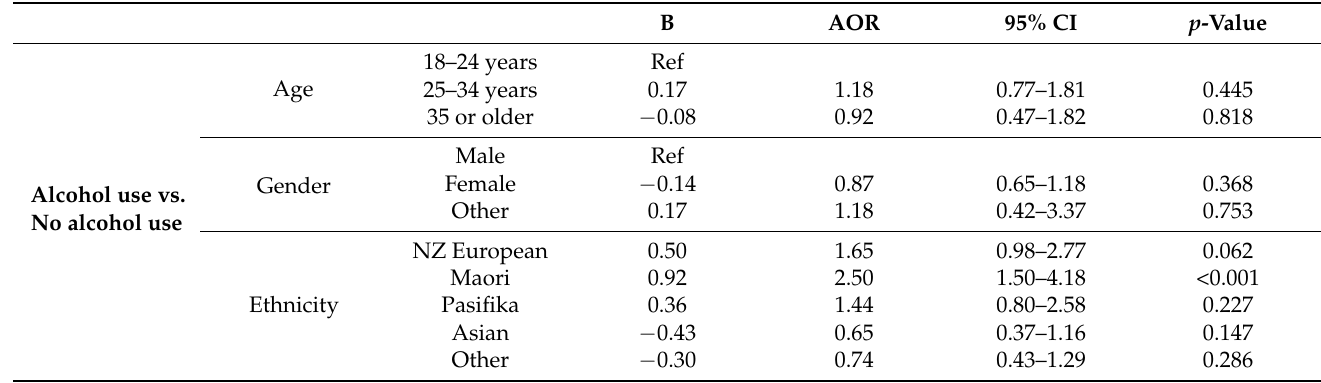
Table 3. Binary logistic models predicting the likelihood of having family/wh¯anau or close friend who consumed alcohol in a harmful way. B AOR 95% CI p -Value